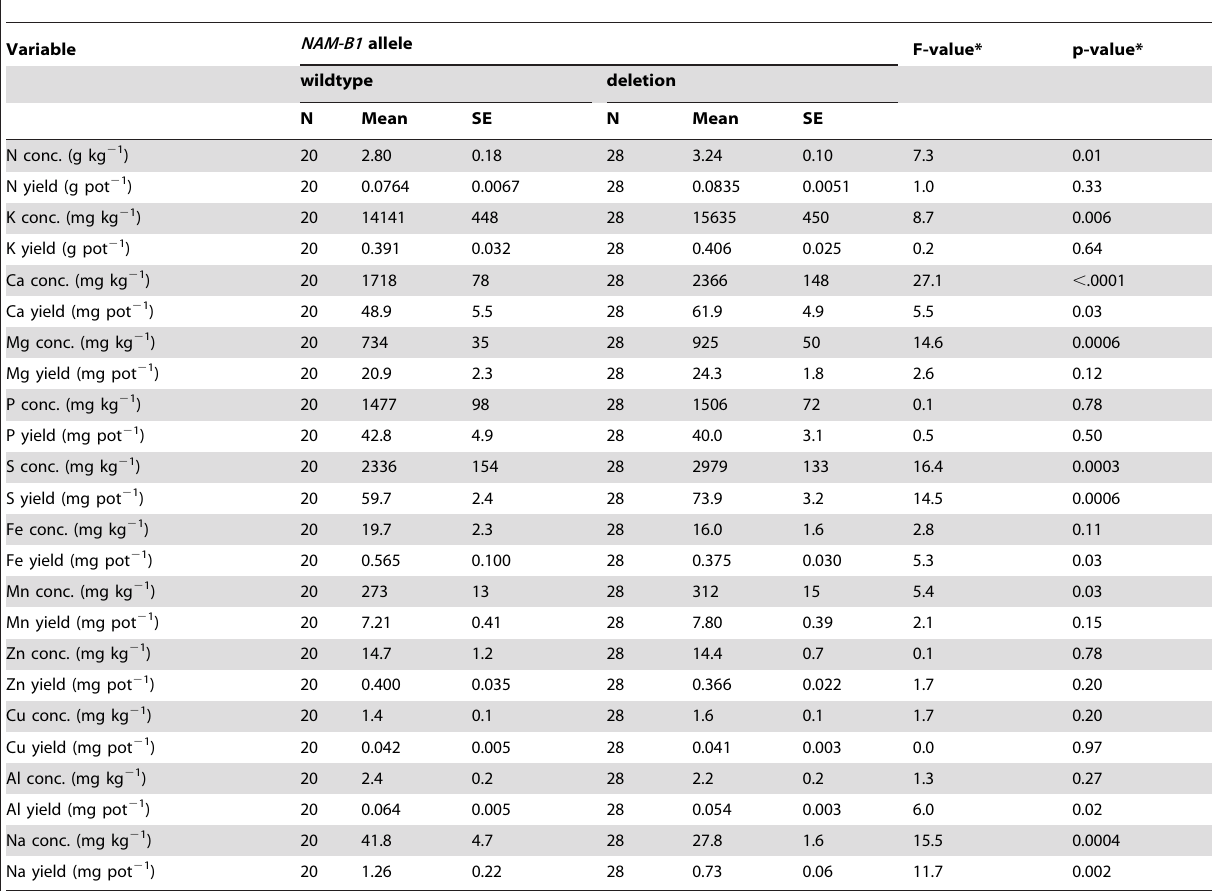
Table 4. Means of concentrations and total amount per pot of some minerals in the straw for a subset of 12 spring wheat varieties, grouped based on NAM-B1